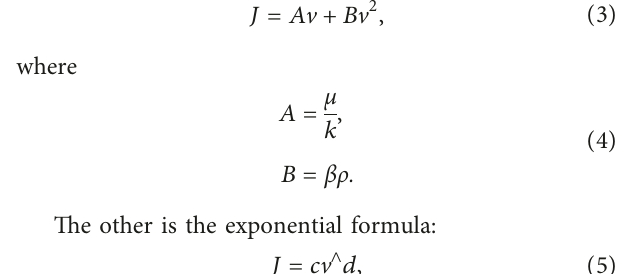
4 . (a) Coal sample. (b) Pores and skeletons. (c) Pores (with an absolute porosity of